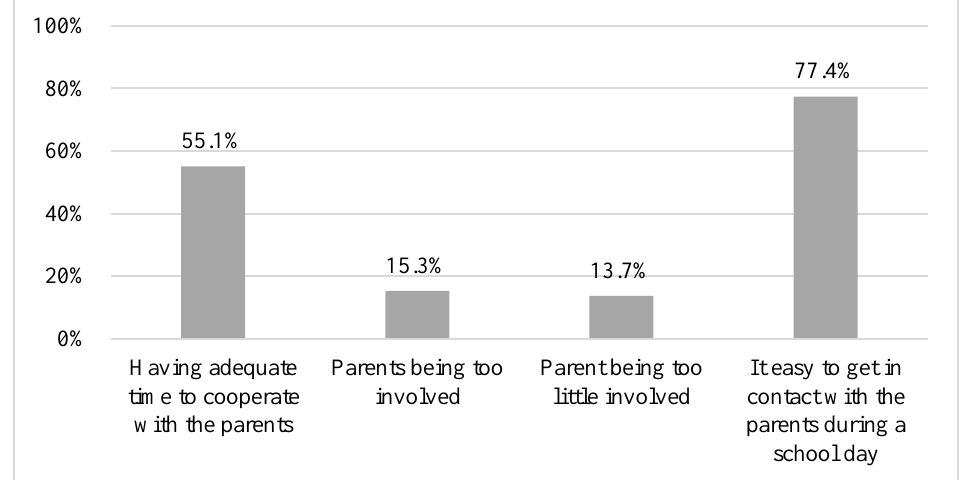
Figure 9. Proportion of schools with parent involvement .